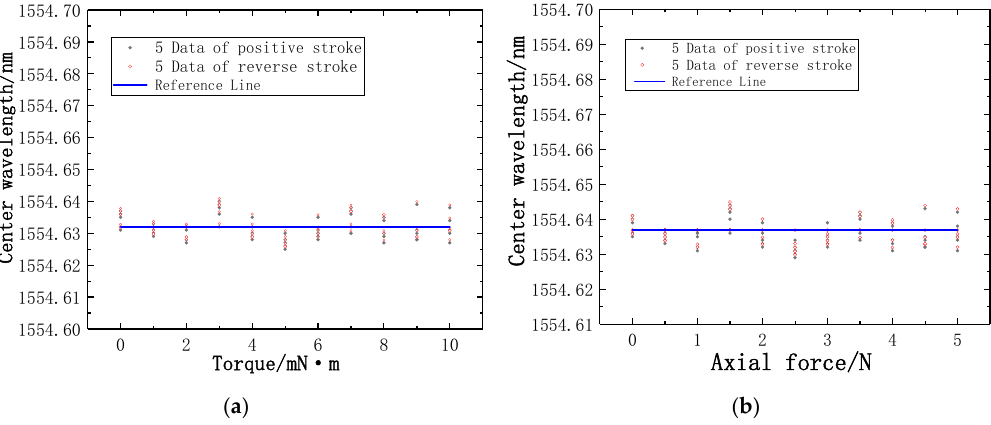
Figure 14. The trend of the values measured by FBG2: ( a ) The trend of the values measured by FBG2 in the torque test; ( b ) the trend of the values measured by FBG2 in the axial force test.